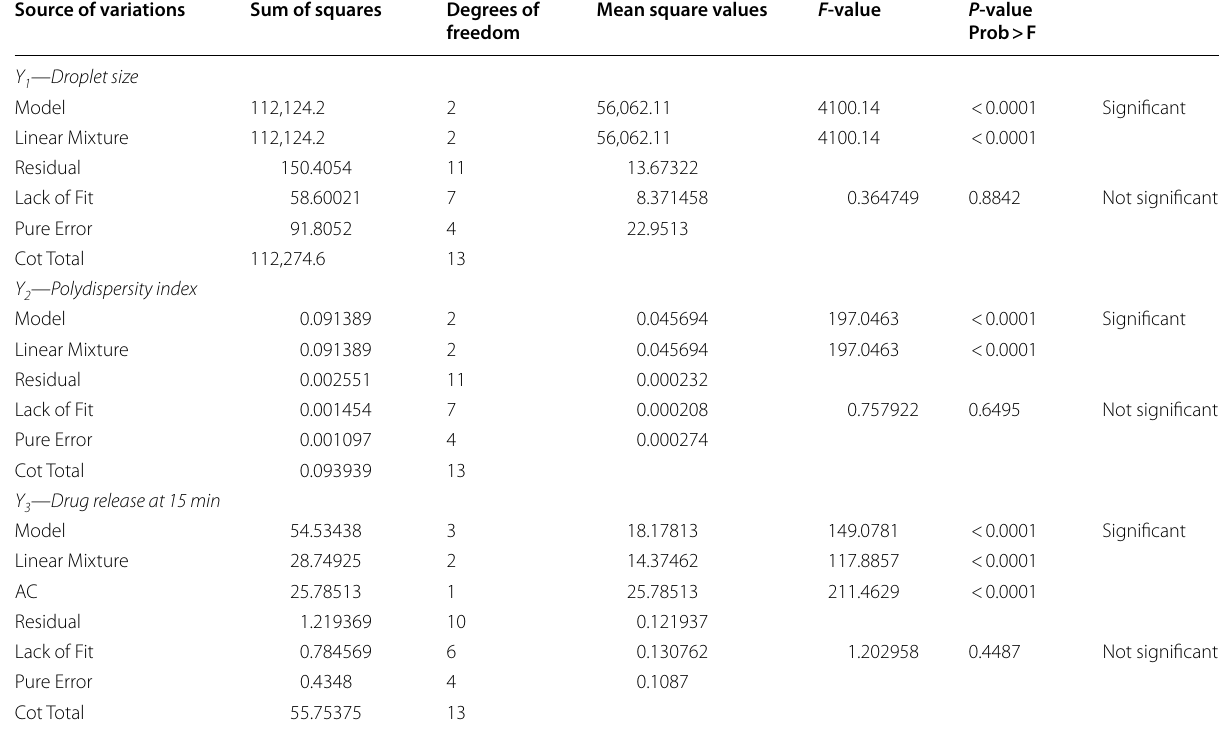
Table 3 ANOVA table of all the three polynomial models Source of variations Sum of